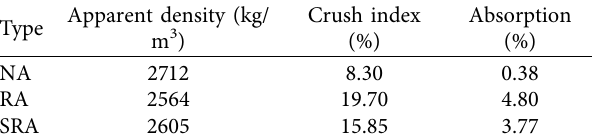
Table 3: Main physical properties of coarse